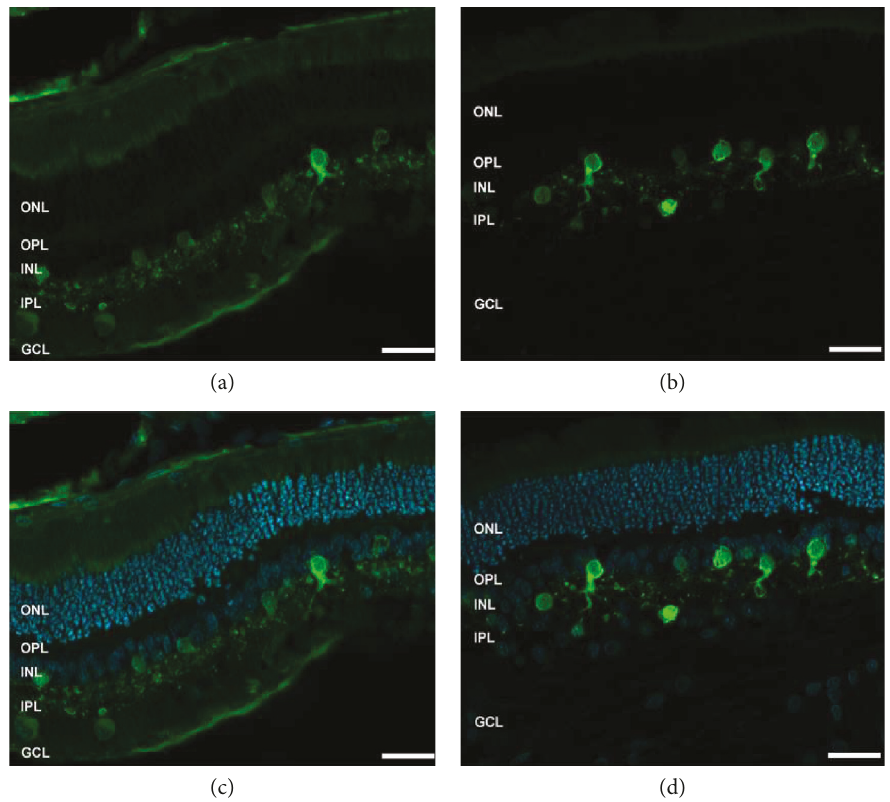
Figure 9: Expression pattern of all amacrine cells in the control and experimental retinas. Representative images of the control retinal sections ((a) and (c)) and detached retinas ((b) and (d)) labelled for calretinin (green) and counter stained with DAPI (blue). IS=inner segment, OS=outer segment, ONL =outer nuclear layer, INL =inner nuclear layer, OPL =outer plexiform layer, INL =inner nuclear layer, IPL =inner plexiform layer, and GCL=ganglion cell layer. Original magni fi cation ×